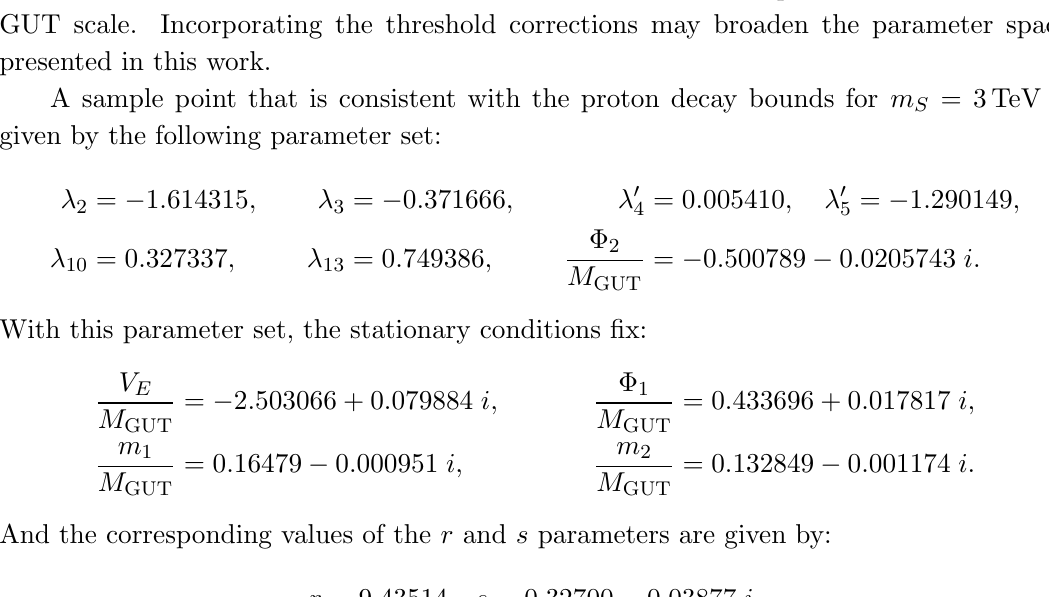
m S 100 TeV with (cid:12)xed (cid:20) (cid:20)